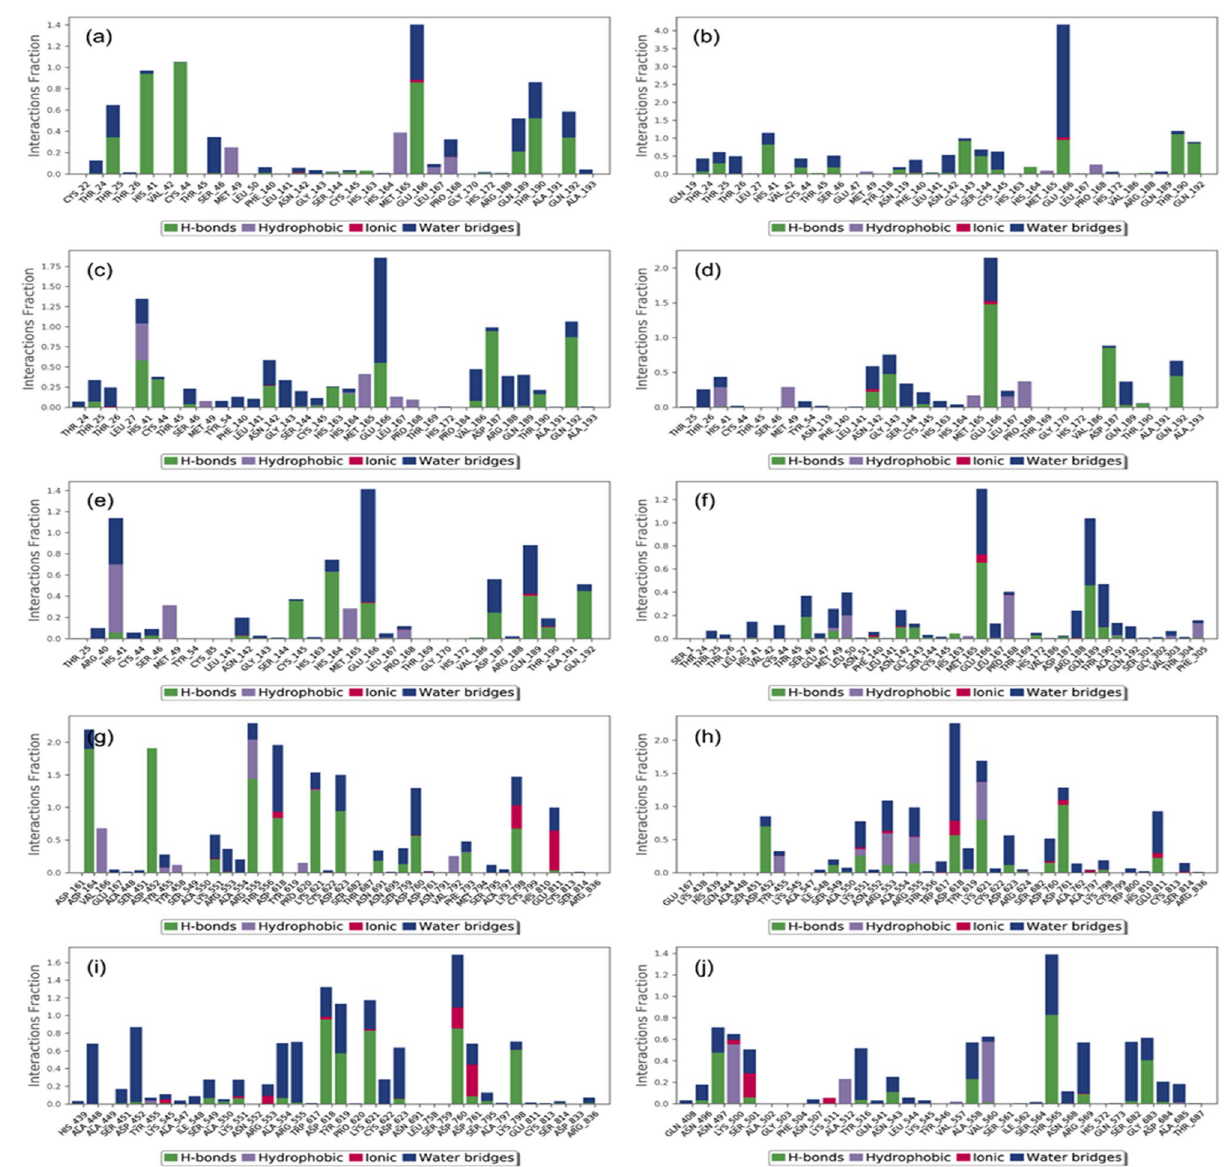
M pro - Proanthocyanidins, ( g ) SARS-CoV-2 RdRp-Echinacoside, ( h ) SARS-CoV-2 RdRp-Rutin, ( i ) SARS- CoV-2 RdRp-Kaempferol-3-O-rutinoside, and ( j ) SARS-CoV-2 RdRp-Quercetin-3-O-xyloside, extracted from respective 100 ns molecular dynamics simulations